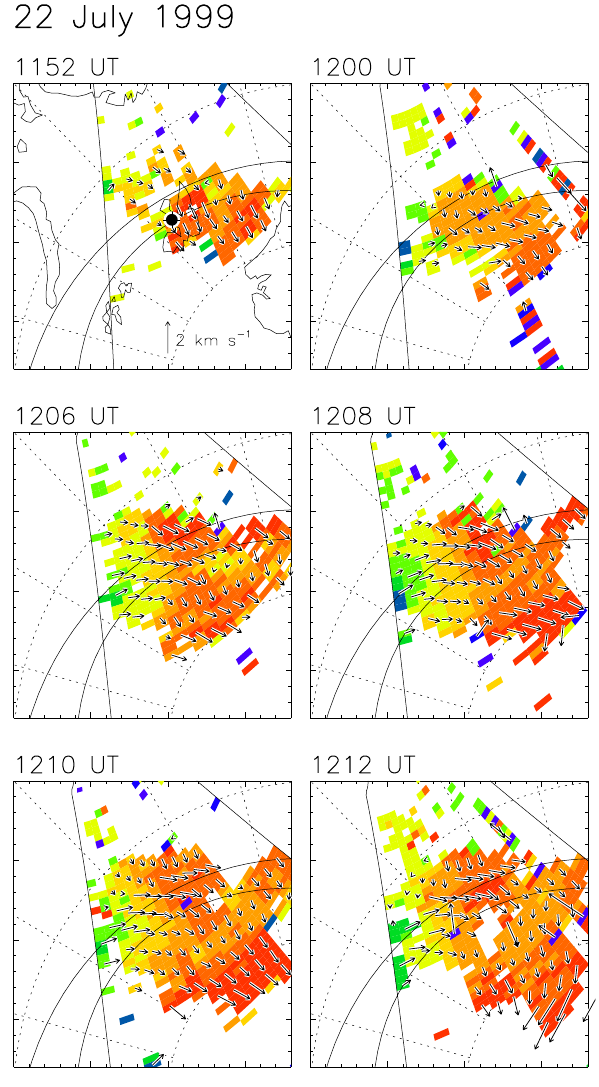
Fig. 10. Similar to Fig. 7 for the 22 July 1999